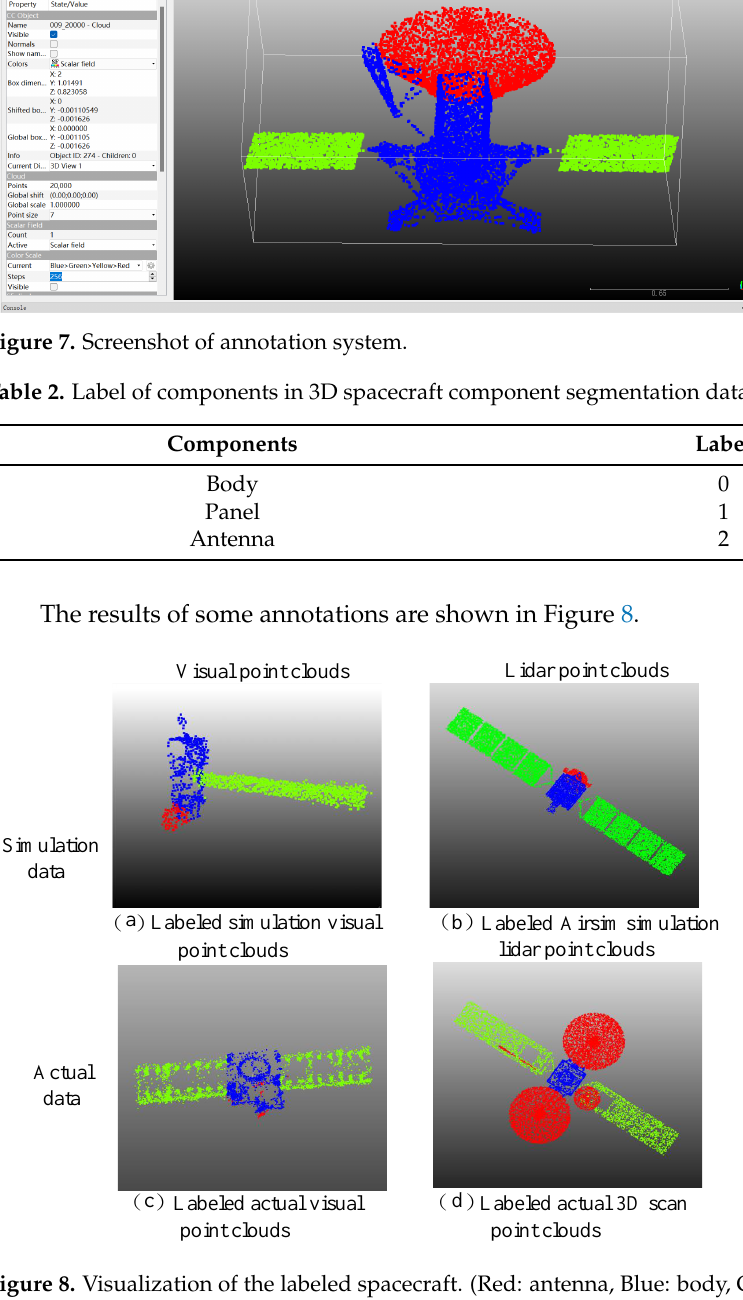
Figure 8. Visualization of the labeled spacecraft. (Red: antenna, Blue: body, Green: